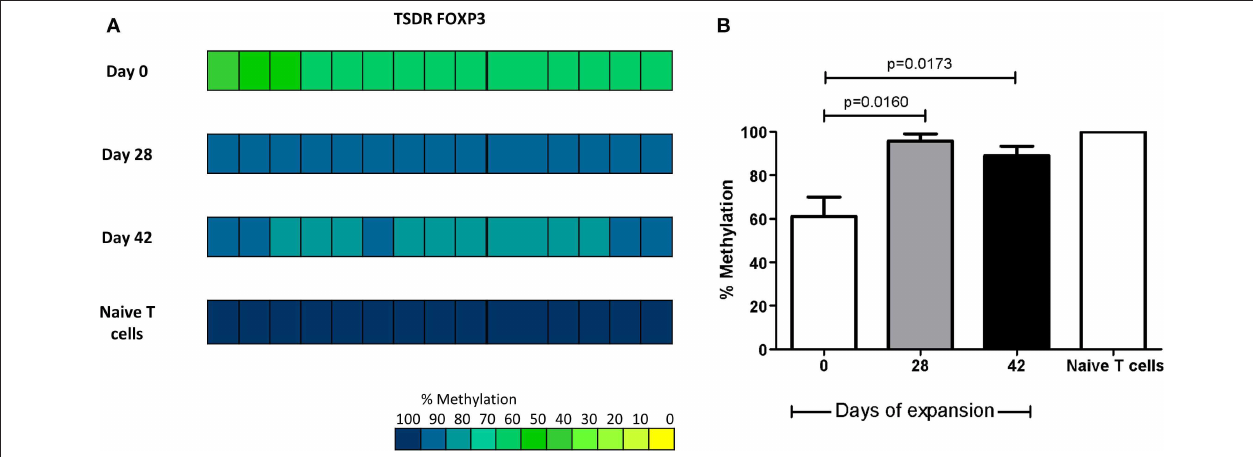
FIGURE 9 | iTregs display partial demethylation of TSDR FOXP3 gene. CpG methylation analysis of TSDR region in FOXP3 gene was evaluated from proliferating CD25 hi cells before (Day 0) and after 4 or 6 weeks of expansion (five individuals per group/six clones per individual. (A) The panel shows the average of methylation status within TSDR FOXP3 from the three evaluated groups. Naïve T cells display a completely methylated TSDR and were used as negative control. Each square represents one CpG analyzed. Methylation color code ranges from yellow (0% methylation) to blue (100% methylation) according to the color scale (lower right). (B) Recently converted iTregs isolated on day 7 of the co-culture with Mo-DCs (Day 0 of the polyclonal expansion) display a partial demethylation of TSDR region ( ≈ 40%); however, when the cells were polyclonally expanded for 4 and 6 weeks, the demethylation is reduced up to ≈ 5 and ≈ 10%, respectively. Percentage of methylation from each evaluated group, represented as the ratio between the numbers of demethylated cytosines and the total number of sequenced CpG sites within the TSDR region. Data are presented as mean of the percentage of methylation ± SEM of five individuals ( n = 5) per group (six clones per individual). The statistical analysis was performed using the non-parametric Mann–Whitney test, two-tailed. P < 0.05 was considered statistically